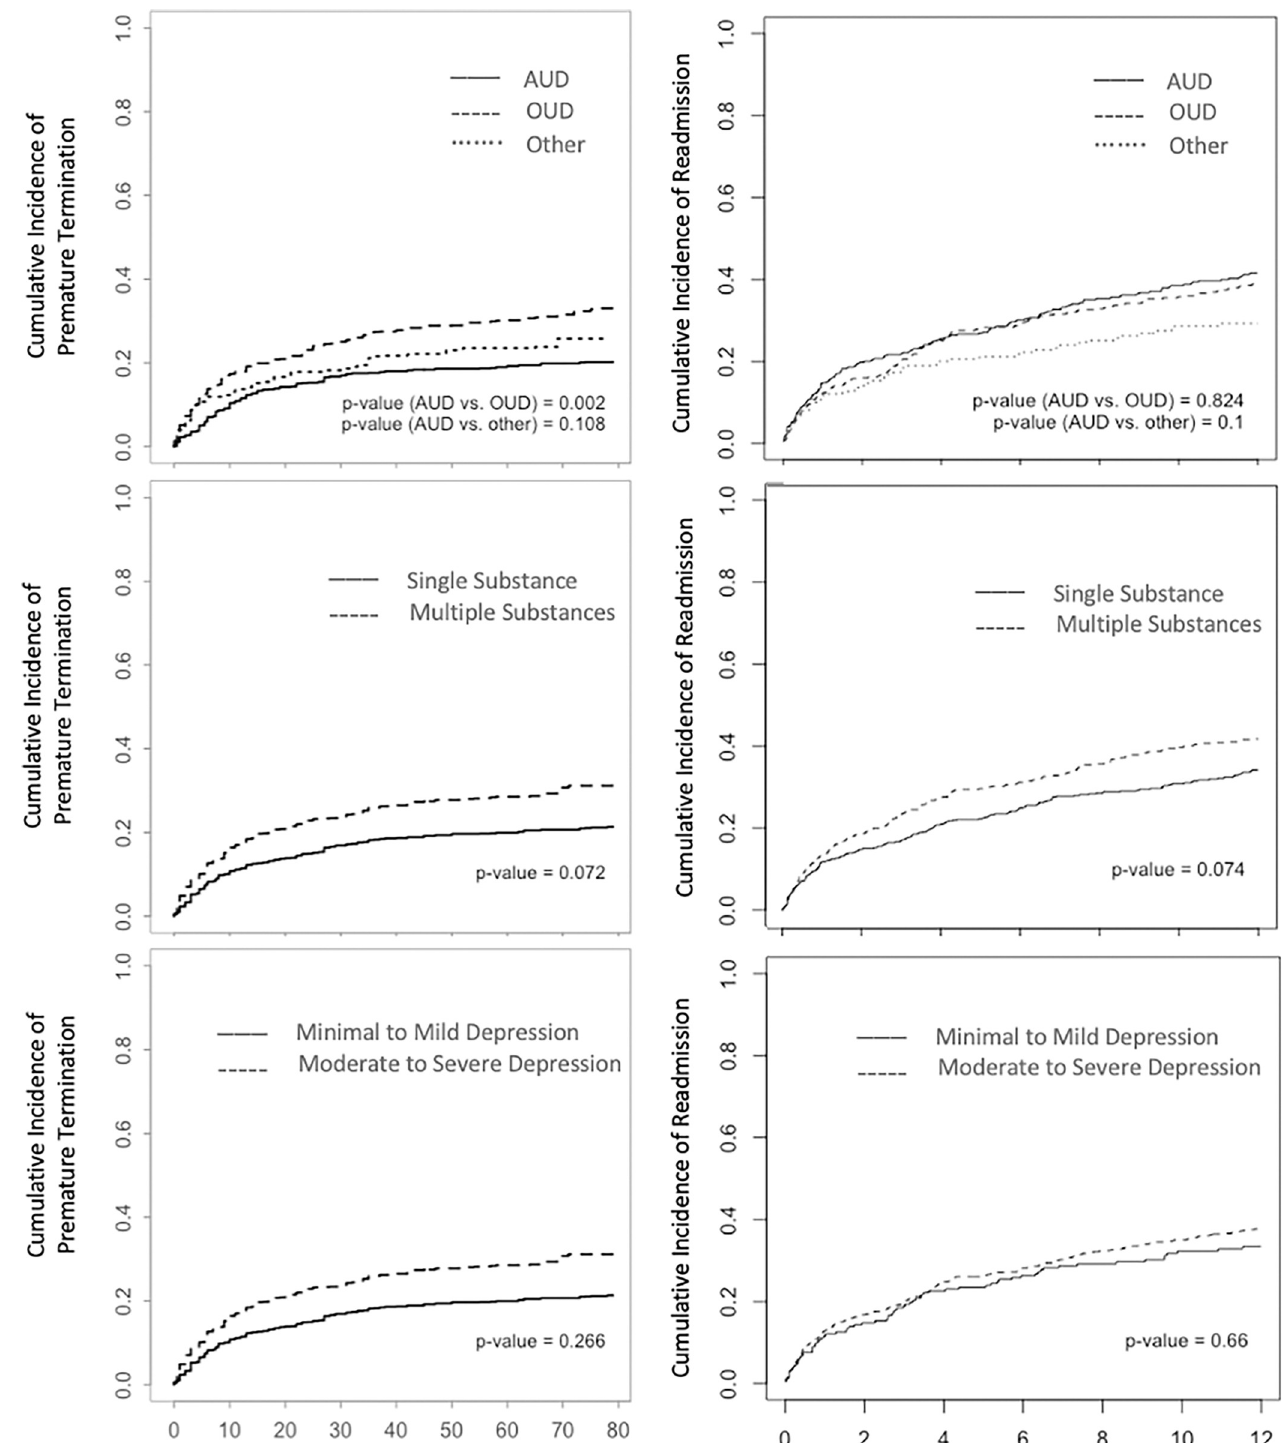
Fig 1. Cumulative incidence of premature treatment termination and readmission by group.